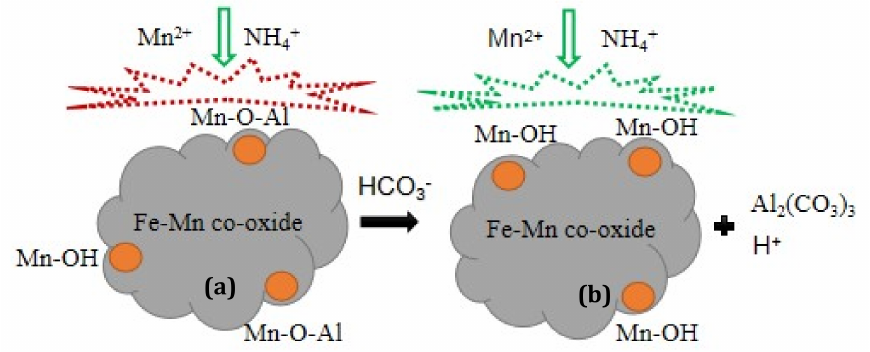
Figure 11. Mechanism of the influence of alkalinity on the NH 4 + and Mn 2 + removal activity of Fe–Mn co-oxide, ( a ) inactivated, and ( b ) active Fe–Mn co-oxide filter